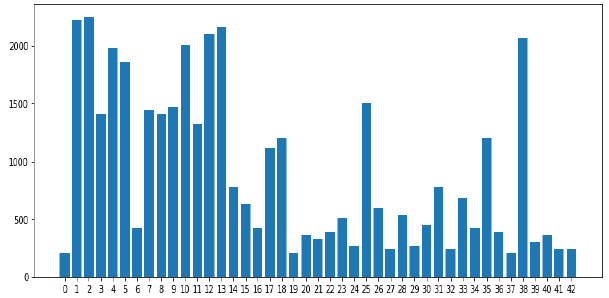
Figure 6. Imbalanced ELVD dataset.